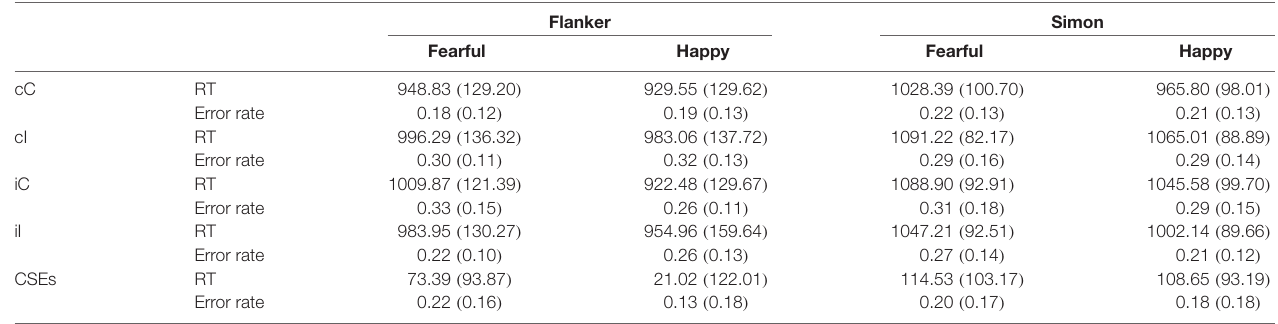
TABLE 1 | The mean reaction time (ms), error rates and magnitudes of emotional CSEs in 5-year-old